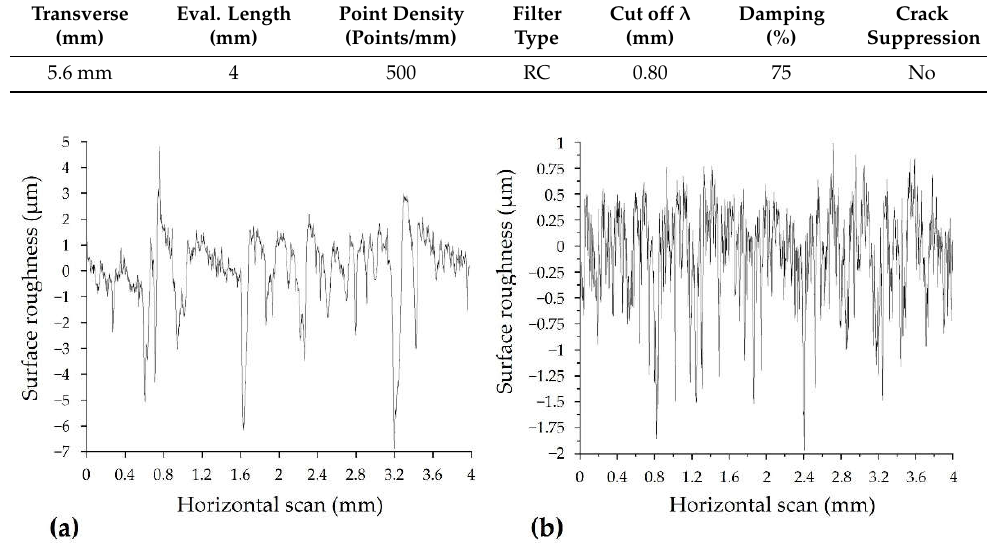
Figure 2. Surface roughness linear profile of ( a ) AISI 430F with drawn finishing and ( b ) AISI 430F with ground finishing.